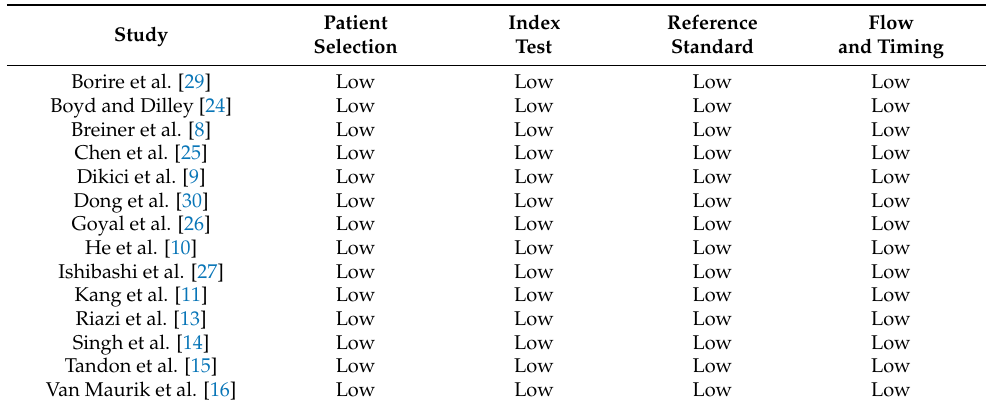
Table 2. Risk assessment using QUADAS-2